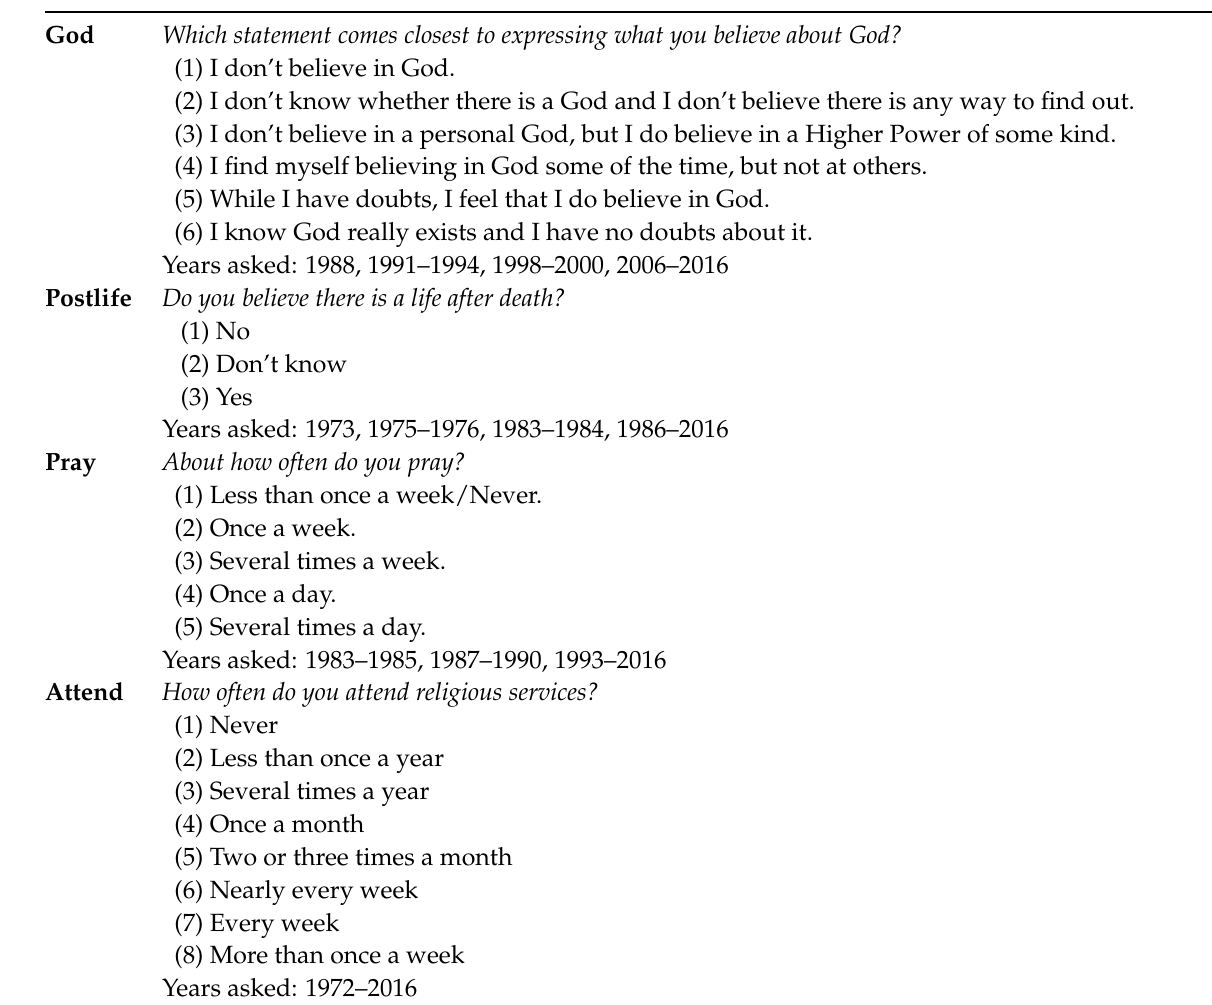
Table 1: General Social Survey questions about religious beliefs and practices used in the analysis. God Which statement comes closest to expressing what you believe about